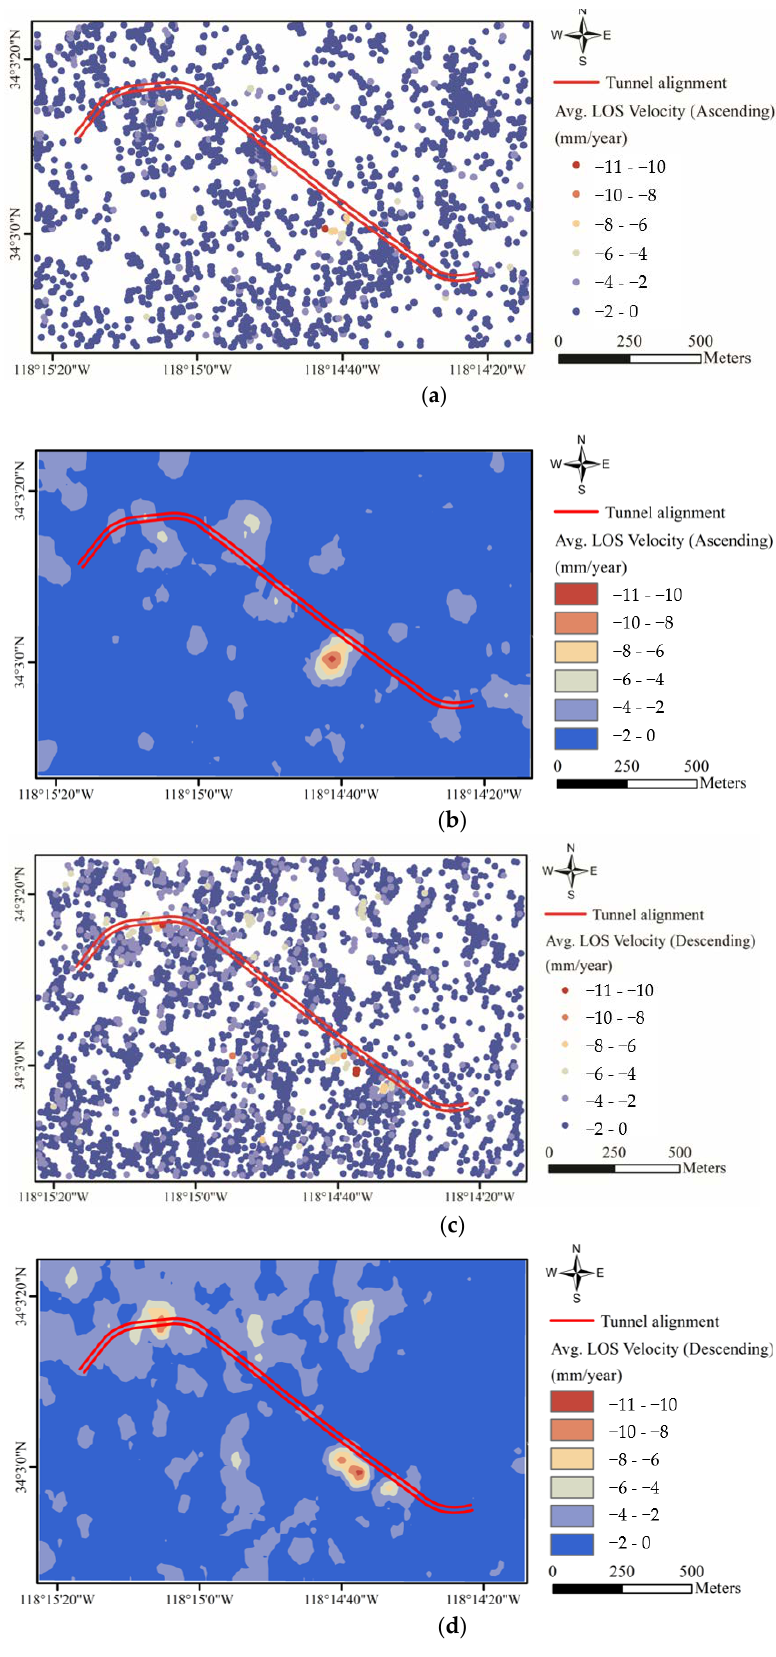
Figure 7. Average LOS settlement map for ascending and descending orbits. ( a , b ) present the LOS velocity from the ascending orbit (path 64). ( c , d ) show the LOS velocity obtained from the descending orbit (path 71). Negative values indicate ground subsidence. The vertical subsidence map (Figure 8) is derived from the LOS subsidence from as- cending and descending orbits. Figure 8 indicates that uneven settlement is concentrated within approximately 6 to 7 times the twin-tunnel diameter buffer. No prominent settle- ments were found outside this scope. Additionally, the measured maximum settlement rate reaches approximately 12 mm/year. Most areas show an average settlement velocity of less than 5 mm/year. Two localized areas appear in yellow and red contours, with av- erage subsidence rates reaching 7 and 12 mm/year. Furthermore, measured ground sub- sidence is within the allowable threshold. No severe damages to aboveground structures were reported.